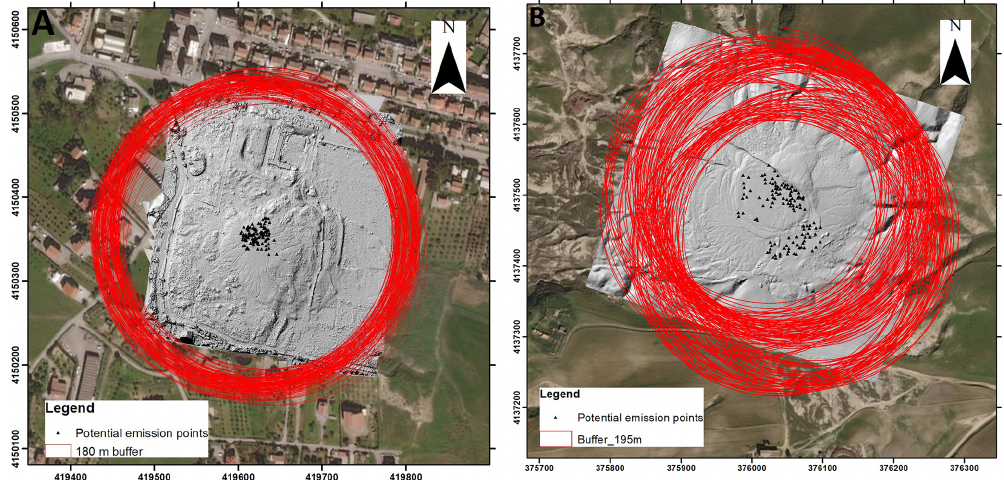
Figure 6. Buffer circumferences in ArcGIS 10.5 in the Santa Barbara (A) and Aragona (B) mud volcano areas (source: 2017 DSMs in ArcGIS 10.5).